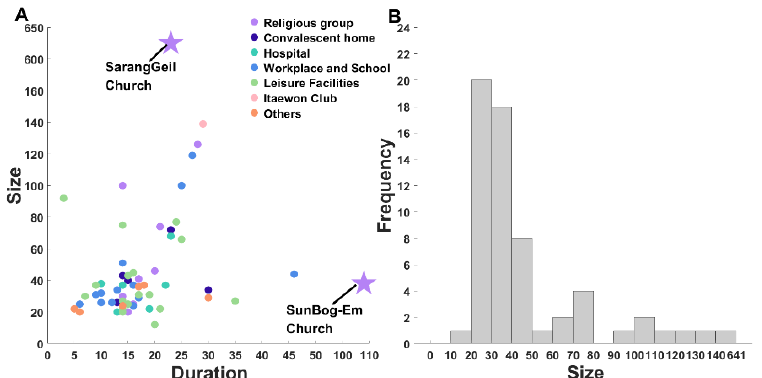
Figure 2. ( A ) The size and duration of 61 clusters categorized by coloring. Sarang Jeil church and Full Gospel church are outliers marked by stars. ( B ) The size and frequency of clusters.